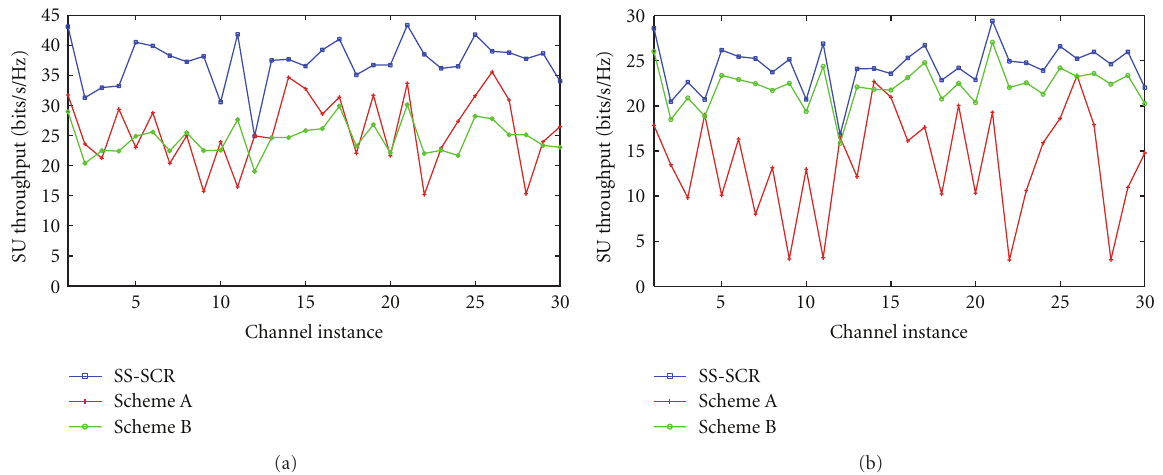
Figure 6: SU throughput versus channel instance (log-normal): (a) high mean OFF time, (b) high mean ON time.